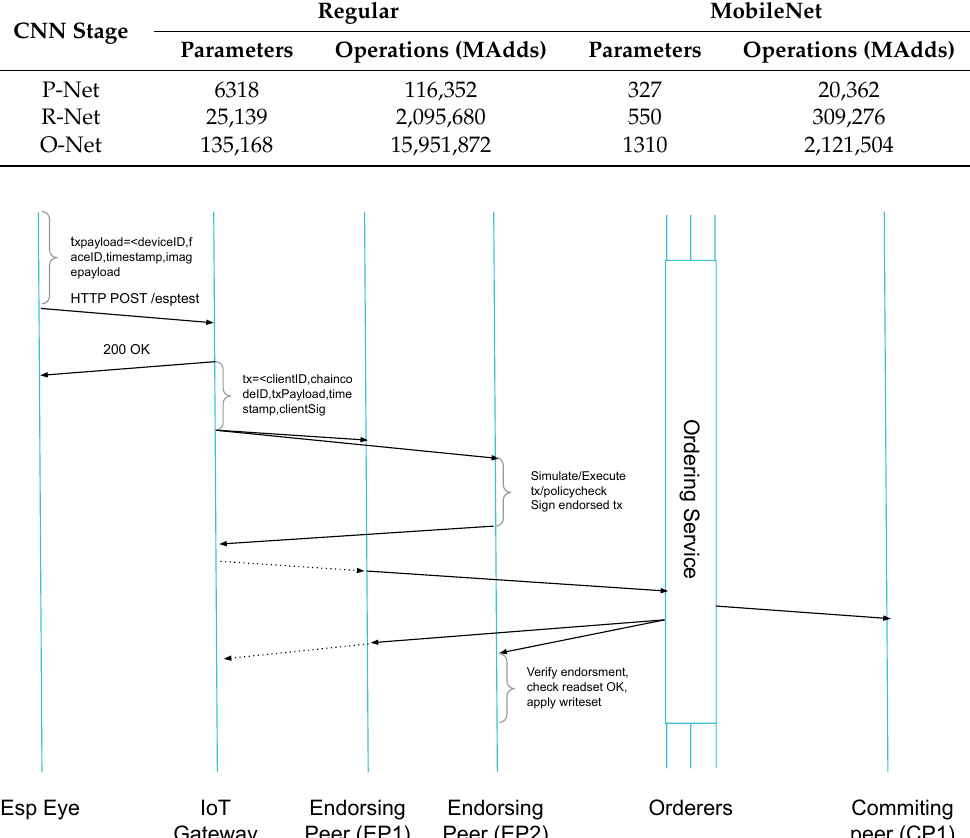
Table 1. MTCNN vs. MTMN.